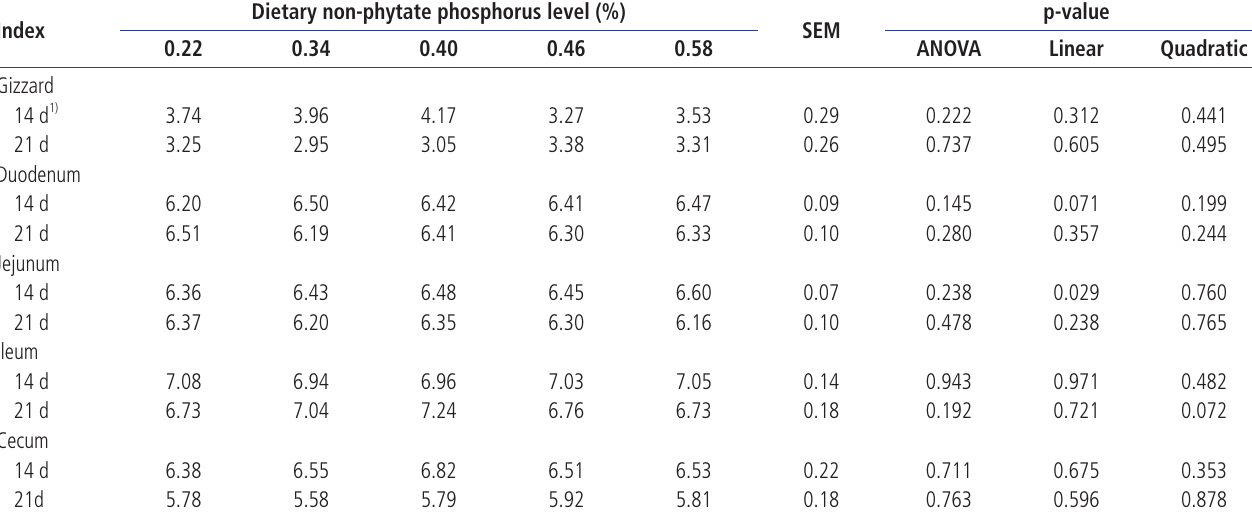
Table 4. Effect of dietary non-phytate phosphorus levels on gastrointestinal pH of ducks